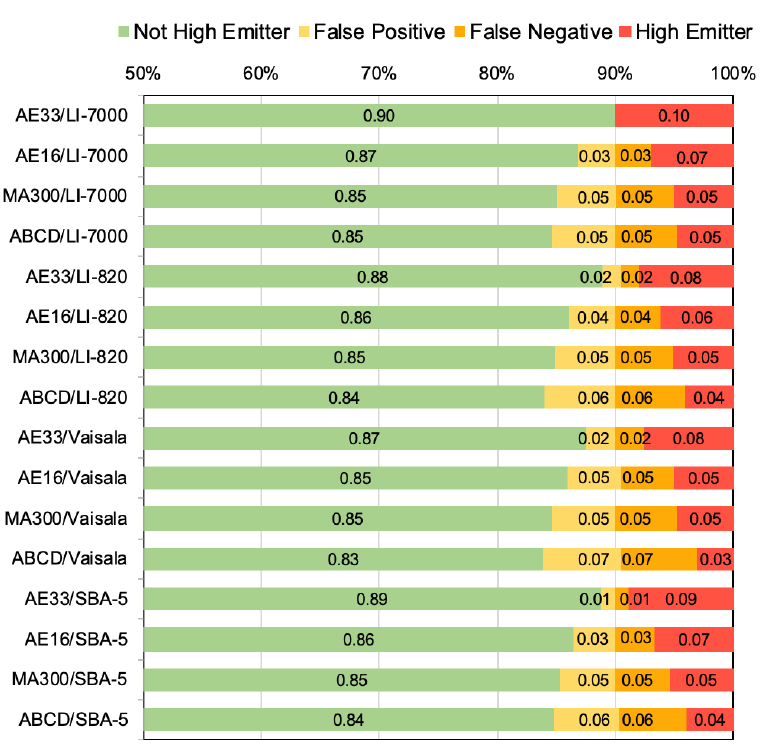
Figure A8. Agreement of high emitter classification across all sensor pairs for the Terminal Entrance fleet. Relative to the highest-emitting 10% of each fleet identified by the highest-cost pair, the AE33 / LI-7000, emission factor distributions for alternative sensor pairs are categorized by those trucks that are also identified as high-emitting (red) and not (green), versus those that disagree and are false positives (yellow) or false negatives (orange). Each bar adds up to 100% of the sampled fleet. Due to rounding, the sum of high emitters and false positives and false negatives may not equal